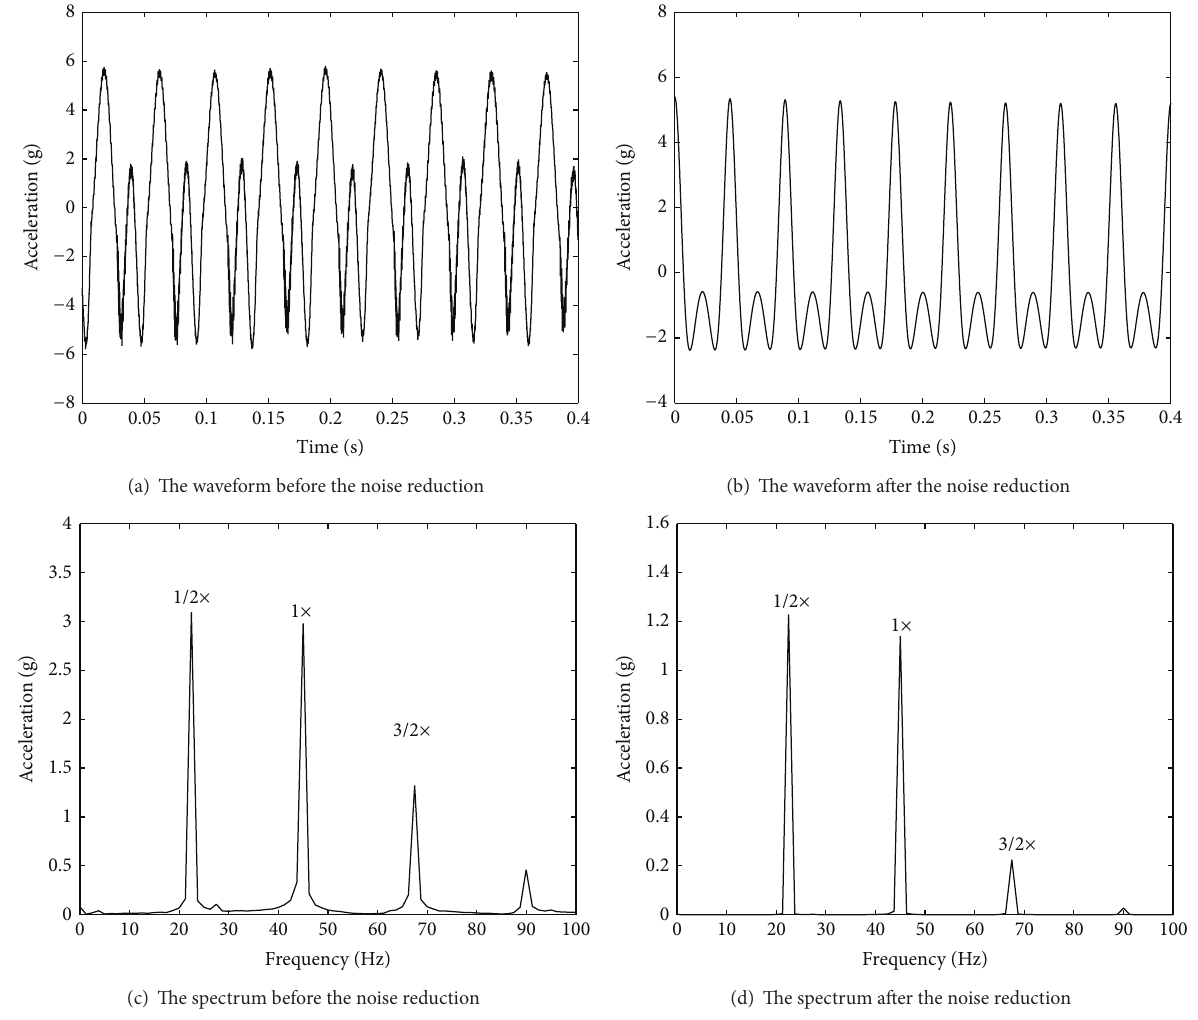
Figure 28: Waveform and frequency spectrum before and after the noise reduction when frequency is 2𝑓 𝑛